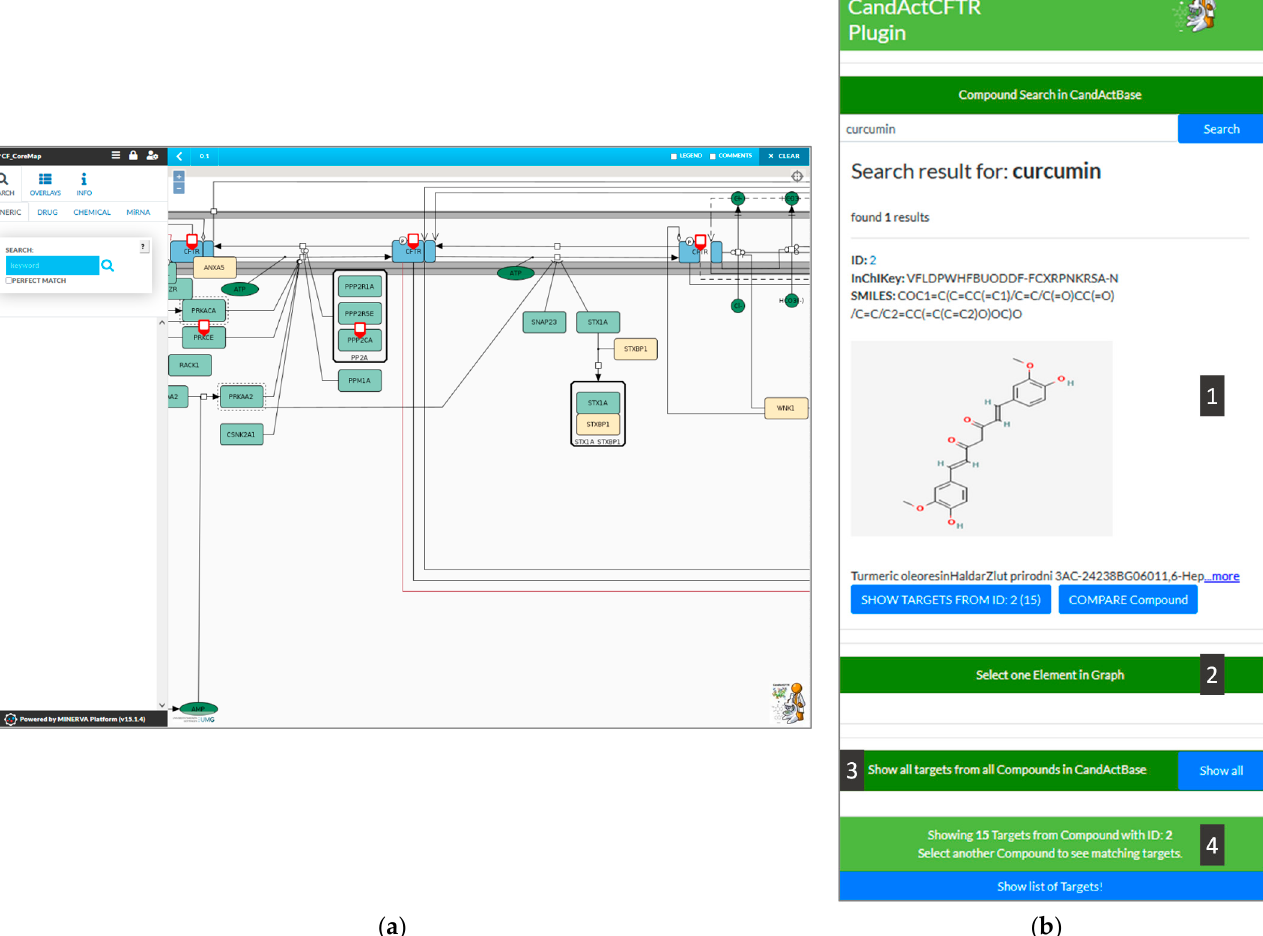
Figure 2. Screenshot from the MINERVA instance showing ( a ) a disease map and highlighted targets, and ( b ) a zoomed-in feature of the UI of the CandActBase plugin. The plugin interface allows the use of all functions from one window: 1. display results from compound query (ID, InChIKey, SMILES Code, chemical structure and synonyms), 2. reverse search by target from disease map, 3. button to highlight all targets of all database compounds in the disease map and 4. button to show targets of selected compound as list.